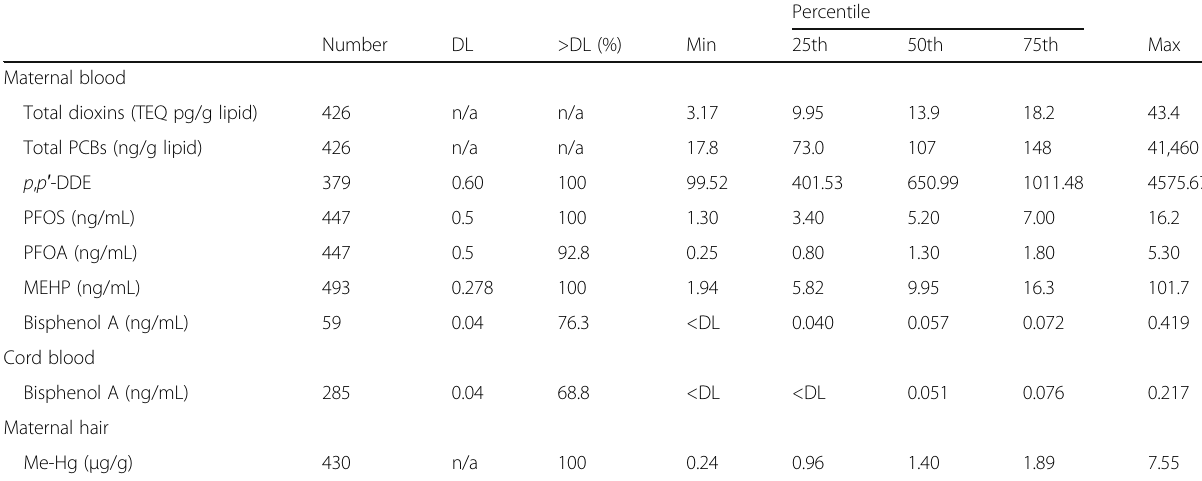
Table 6 Exposure levels of environmental chemicals in the Sapporo cohort